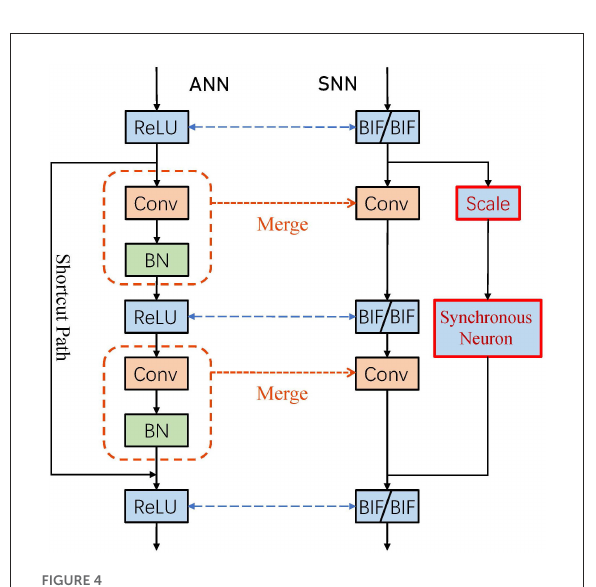
FIGURE4 Synchronous neurons for spiking ResNet.